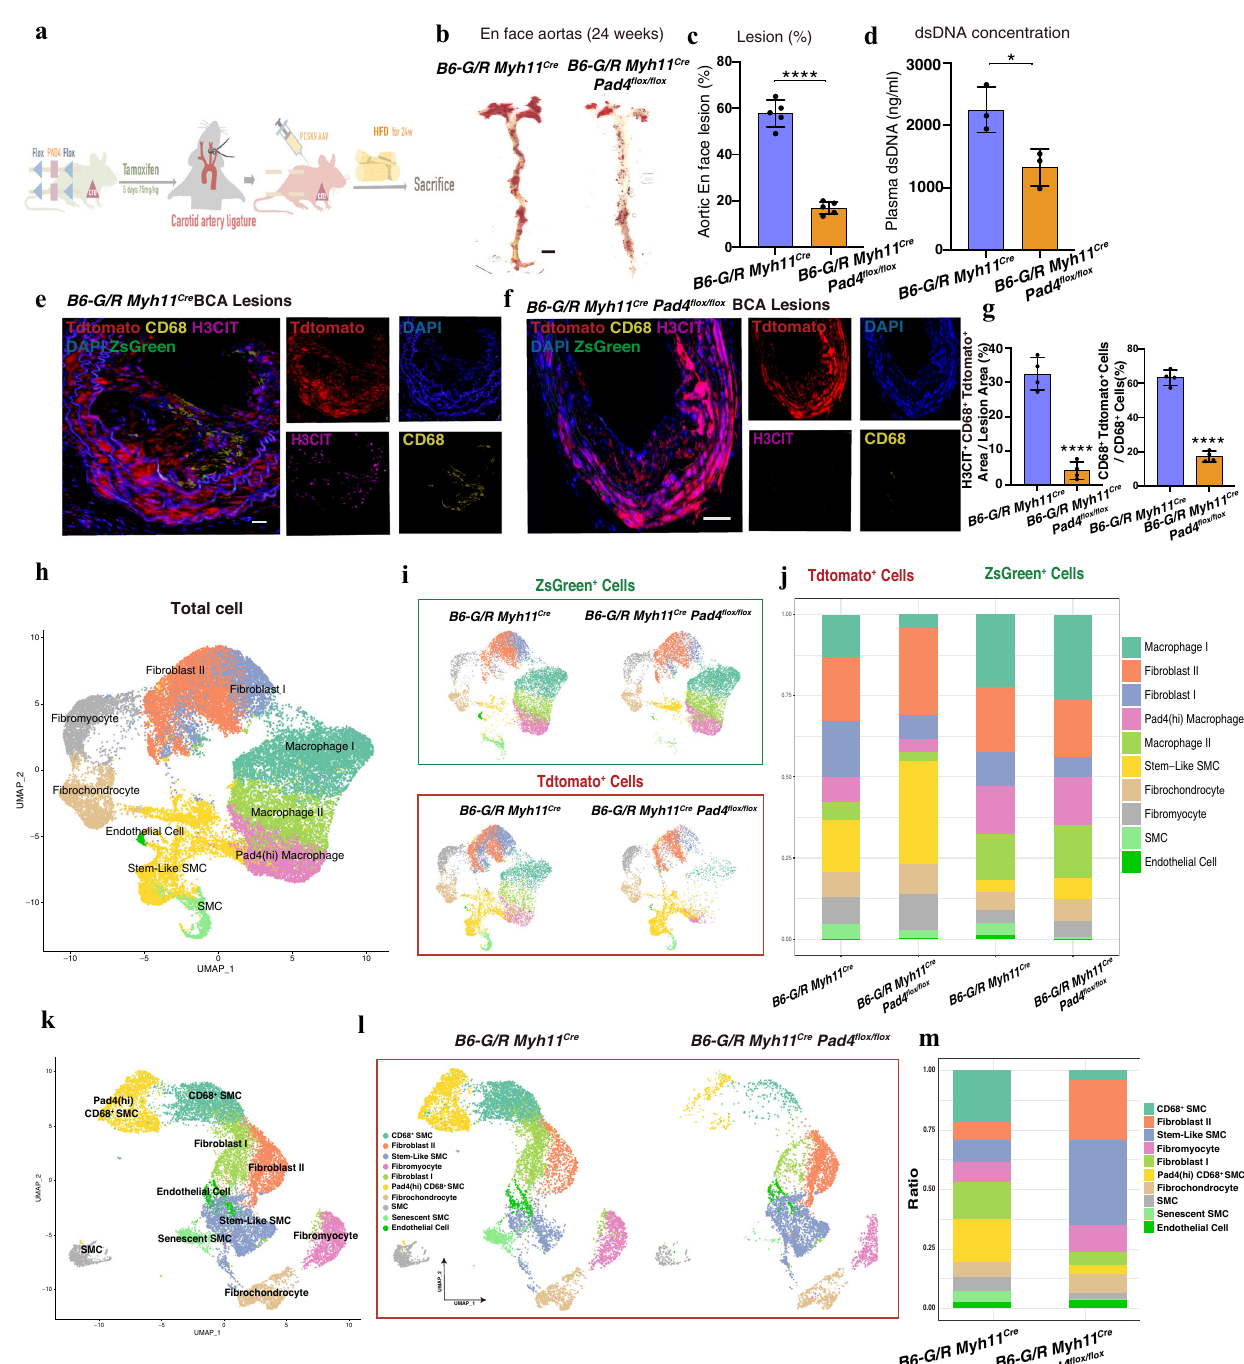
Fig. 4 | ET Inhibition Reduced the CD68 + VSMCs and scRNA-seq Identi fi ed Multiple VSMCs-derived Cell Types During Advanced Atherosclerosis Plaque. a Schematic diagram of the procedure of HFD fed B6-G/R Myh11 Cre Pad4 fl ox/ fl ox mice and B6-G/RMyh11 Cre miceforbothtimepoints. b , c OilredO-stainedaortasisolated from 24weeks HFD-fed mice between 2 groups and related quanti fi cation (each group n =5mice).**** p <0.0001.Scalebar=0.5cm. d Theconcentrationofplasma dsDNAharvested from micebetween groups(eachgroup n =3 mice).* p =0.0265. e , f IF staining of H3CIT or CD68 in BCA plaque lesions between groups, respec- tively.Scalebar=50 μ m. g ThepercentageofH3CIT + Tdtomato + andCD68 + areain the total lesion area of the BCAs and the percentage of the number of CD68 + Tdtomato + cells in the total number of CD68 + Cells (each group n =4 mice). **** p <0.0001. h , i Uniform manifold approximation and projection(UMAP)